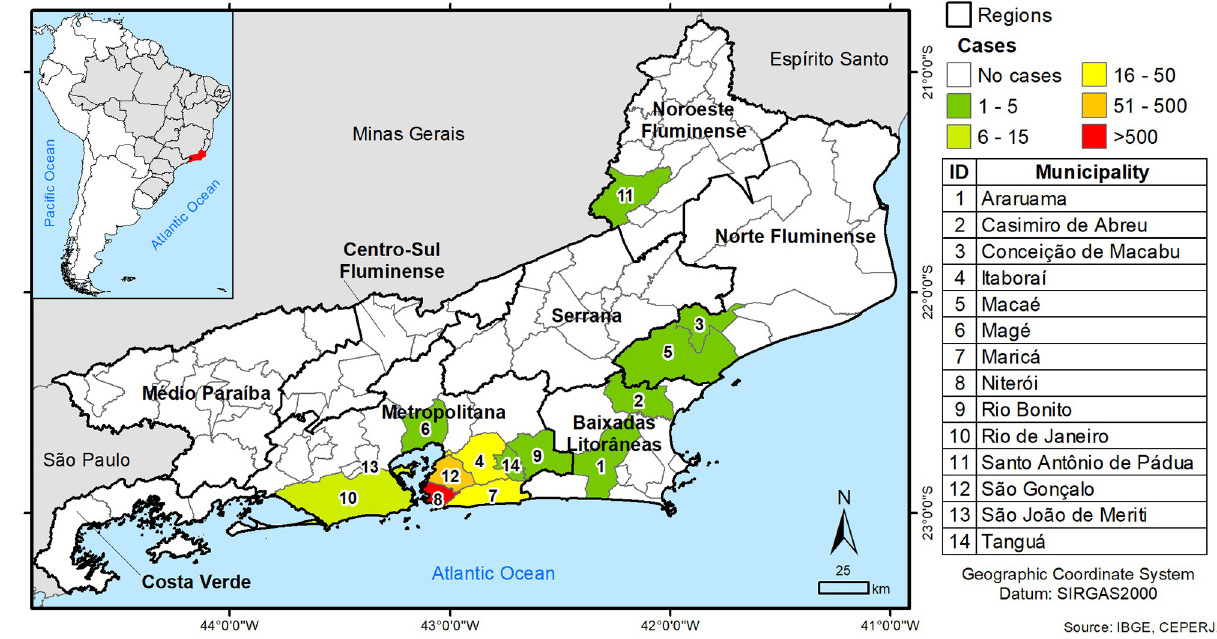
Fig 1. Rio de Janeiro state (study area), Regions and the municipalities from which patients with dermatophytosis (cases) originate (https://www. ibge.gov.br/en/geosciences/downloads-geosciences.html).